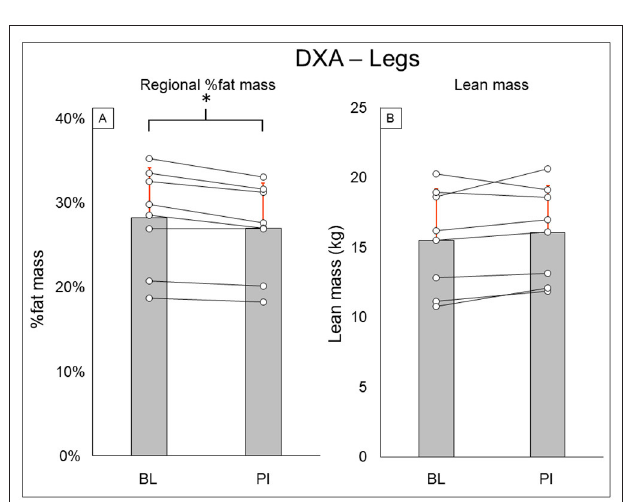
mass (BL: 50.3 ± 8.9 kg, PI: 51.2 ± 8.7 [ + 1.9%], P = 0.123) and total body mass (BL: 77.5 ± 20.5 kg, PI: 75.8 ± 18.1 [ − 2.1%], P = 0.263) did not change after training. Leg DXA results are summarized in Figure 3 . Leg percent fat mass (BL: 28.2 ±